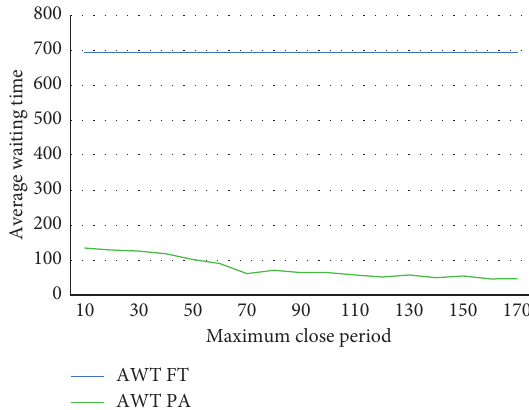
Figure 20: Effect of changing the maximum close period on the average waiting time using FT and PA algorithms.